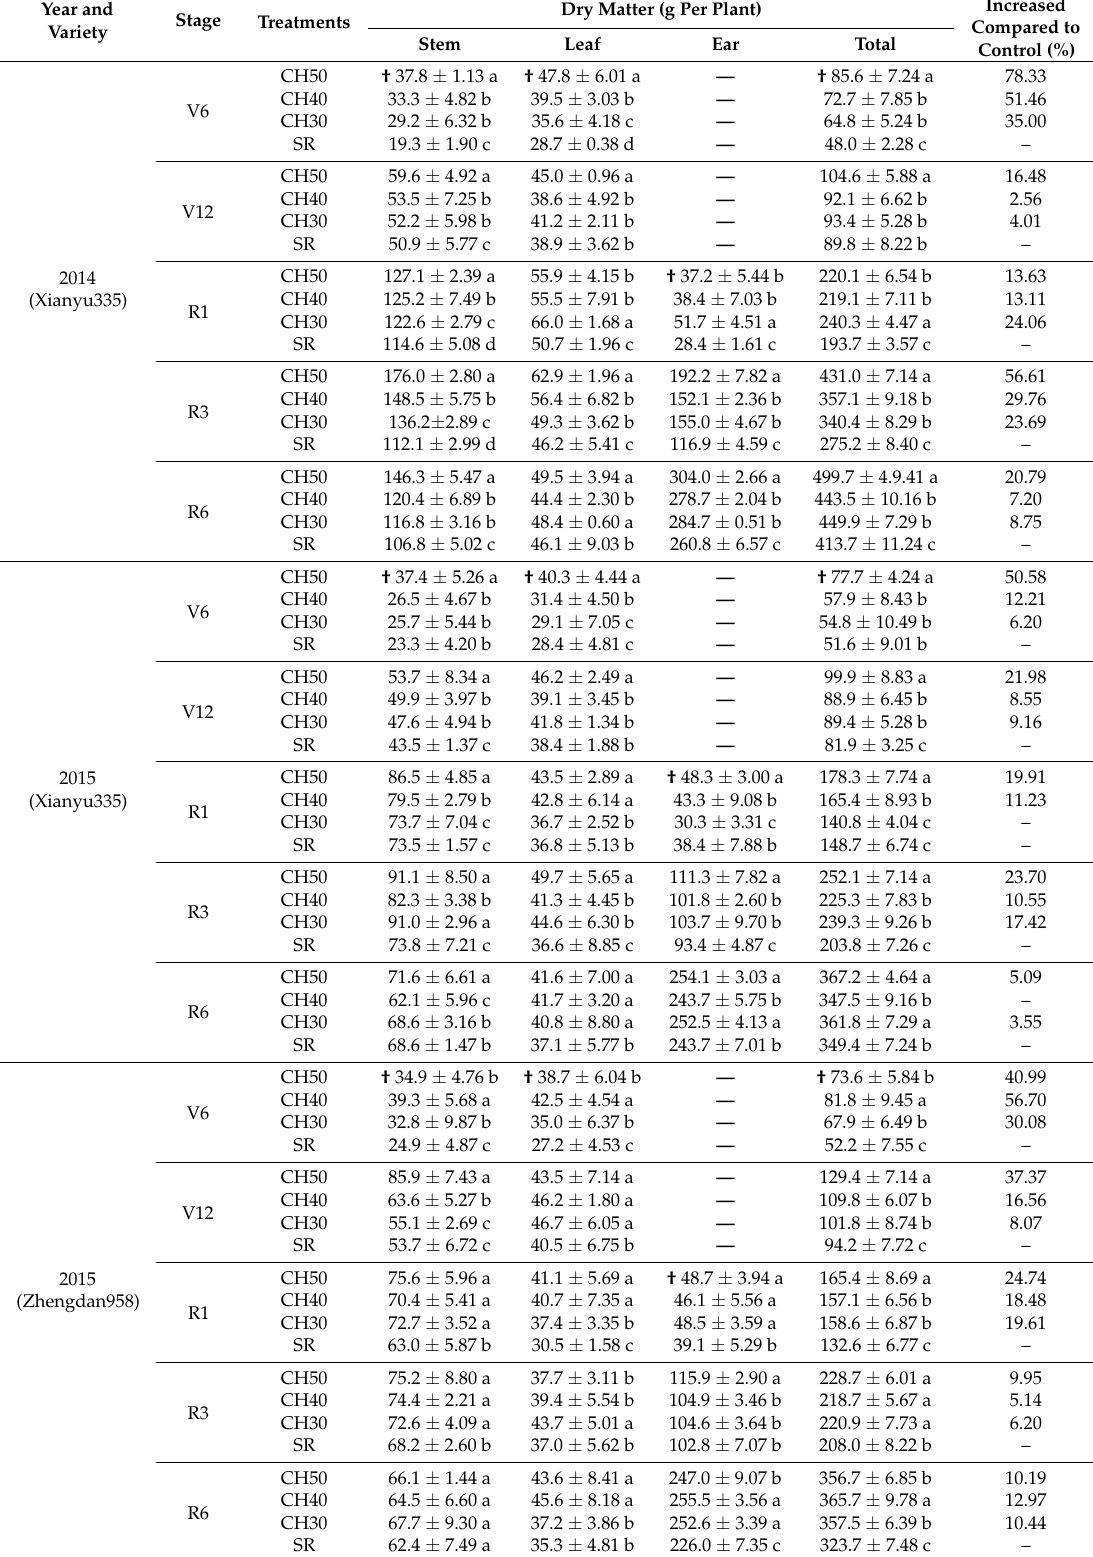
Table 2. Effect of subsoil tillage treatments on the accumulation of Xianyu335 dry matter at different growth stages in 2014. Values are the average ± 1 standard